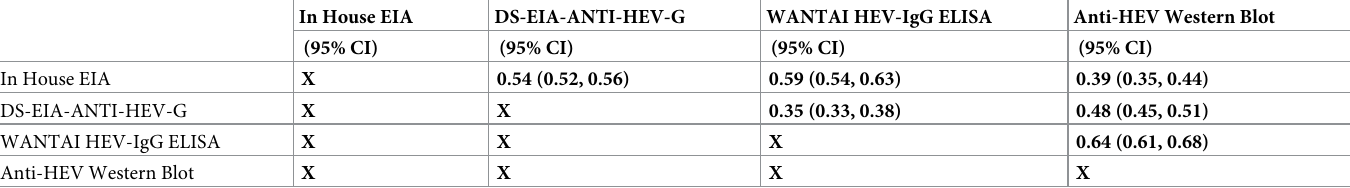
Table 5. Kappa agreement of HEV assays from NHANES